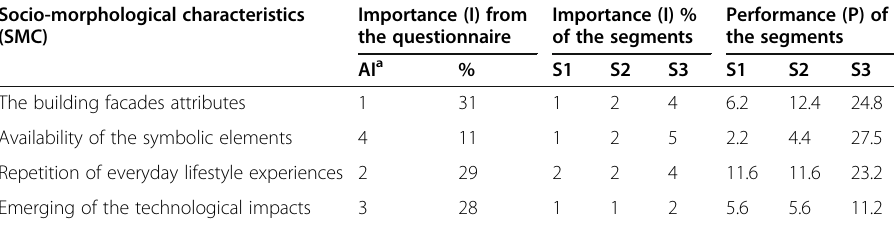
Table 3 The degree of performance for each segment of the street examined by the researchers Socio-morphological characteristics (SMC)